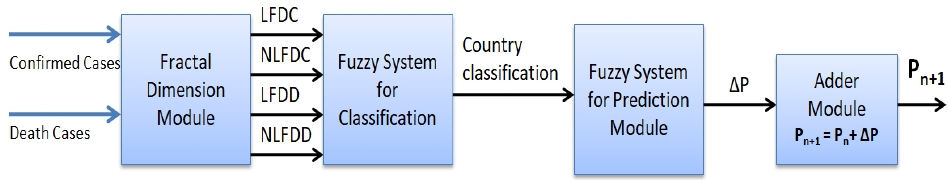
Figure 15. Structure of the approach for time series prediction.